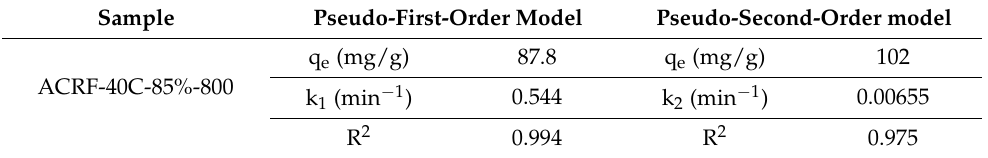
Figure 9. CO 2 adsorption kinetics of ACRF-40C-85%-800. Table 2. Kinetics model parameters for CO 2